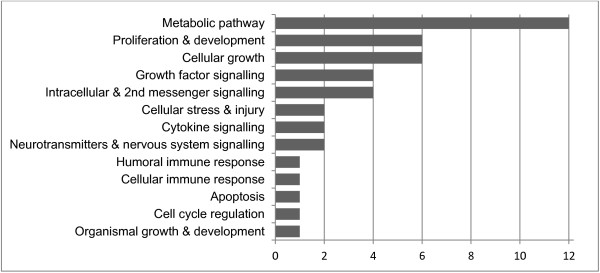
Pathway categories that were affected by the level of the anti-CMV IgG titre. The numbers of pathways in the indicated pathway categories for nonagenarians are listed. Canonical pathways that were affected by the anti-CMV IgG titre are grouped into pathway categories that are defined in the Ingenuity Knowledge Base®. One canonical pathway can belong to several categories.